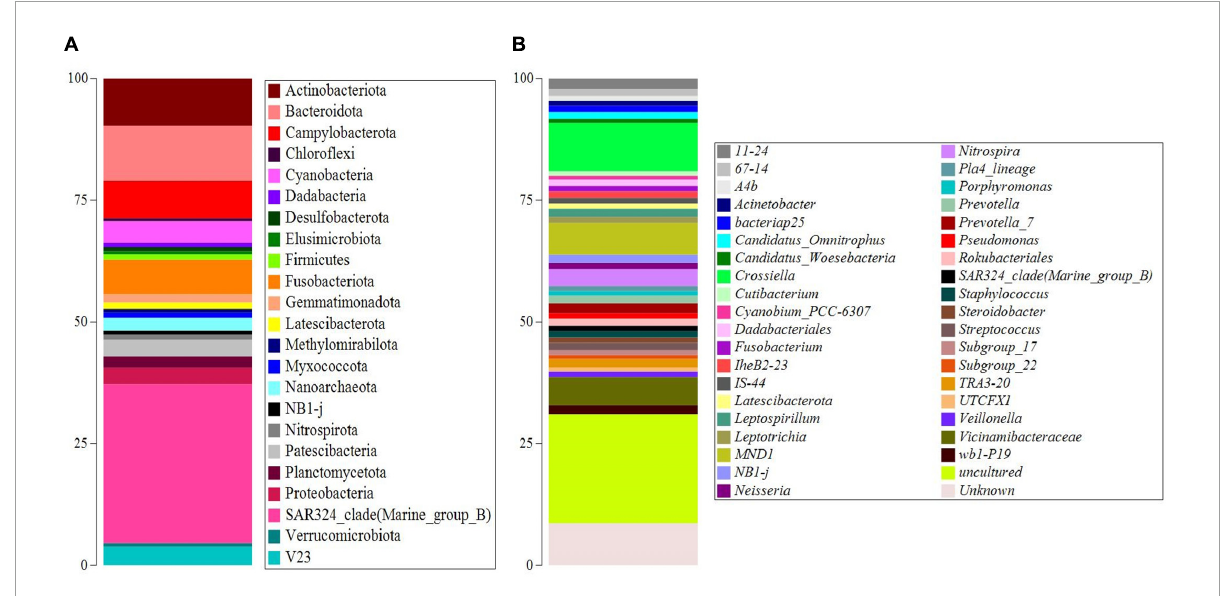
FIGURE2 Taxonomy barplots of the main ASVs (abundances > 0.5%) at phylum (A) and genus level (B) .